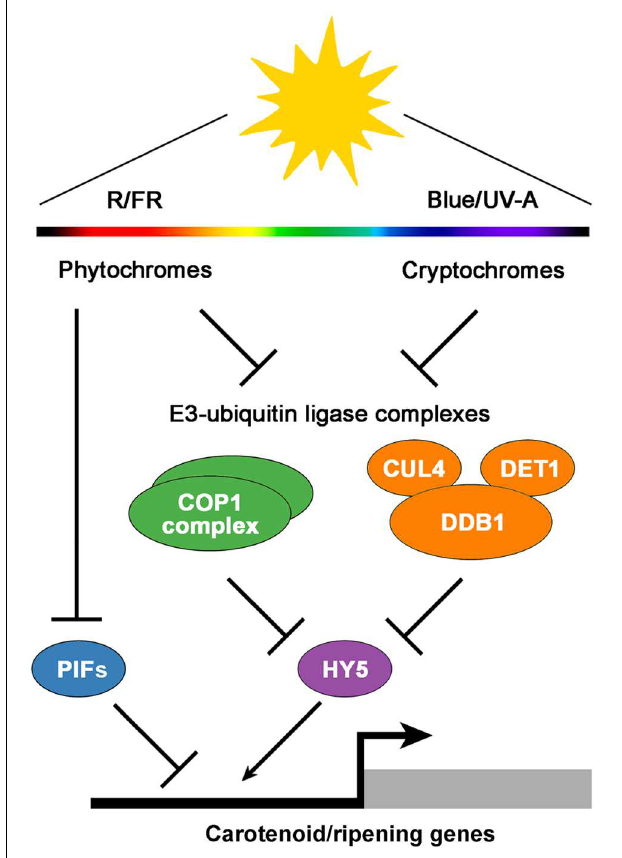
FIGURE 1 | A simplified model of light signaling components involved in the regulation of tomato fruit pigmentation and ripening. Fruit- localized phytochrome and cryptochrome photoreceptors regulate the activity of the downstream E3-ubiquitin ligase COP1 and CUL4-DDB1-DET1 complexes, which in turn mediate the degradation of the transcriptional activator HY5. In addition, active phytochromes reduce the activity of transcriptional repressors such as PIFs. The balance between activators and repressors finally modulates the expression of carotenoid and ripening- associated genes. R, red light; FR, far-red light; Blue, blue light; UV-A, ultraviolet-A